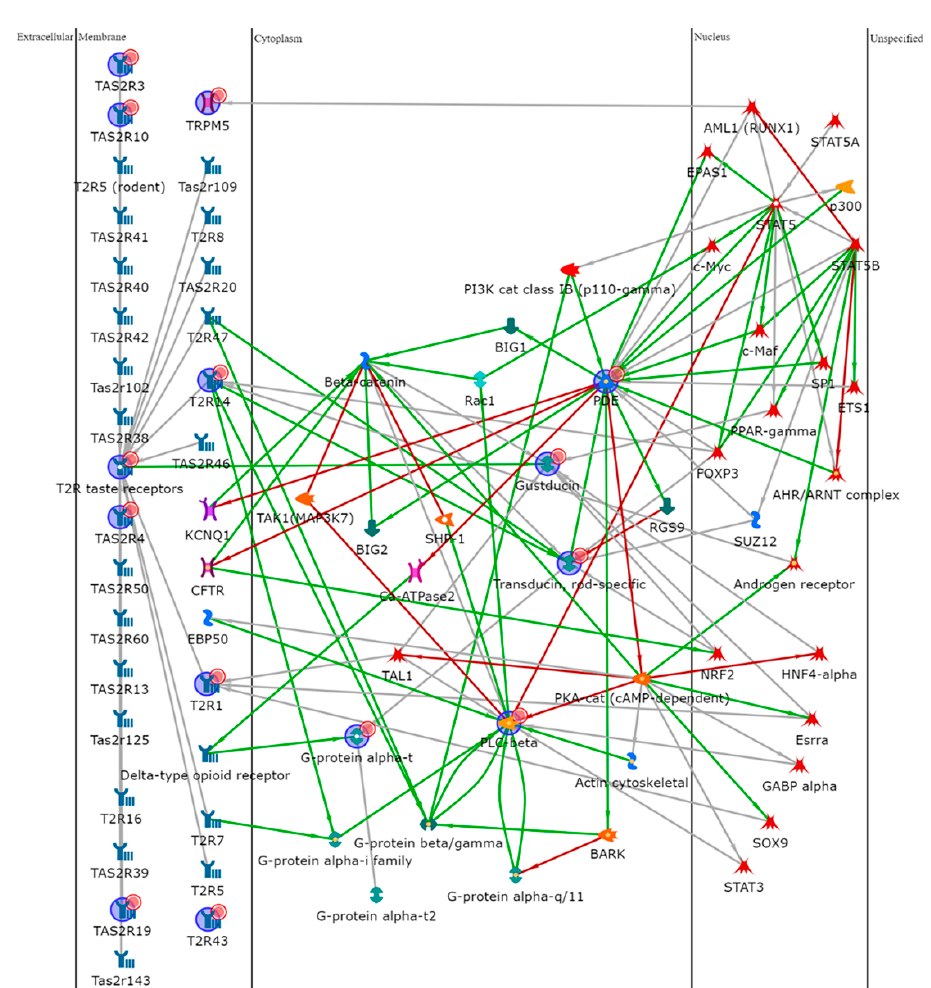
Figure 5. Protein network analysis of all the factors involved in this study, made using MetaCore software. PDE4A, PLCB2, GNAT1, GNAT3, and T2R14 were central functional hubs of the net built by shortest path algorithm. Only closely related proteins were included in the resulting path prioritized according to their statistical significance ( p ≤ 0.001).